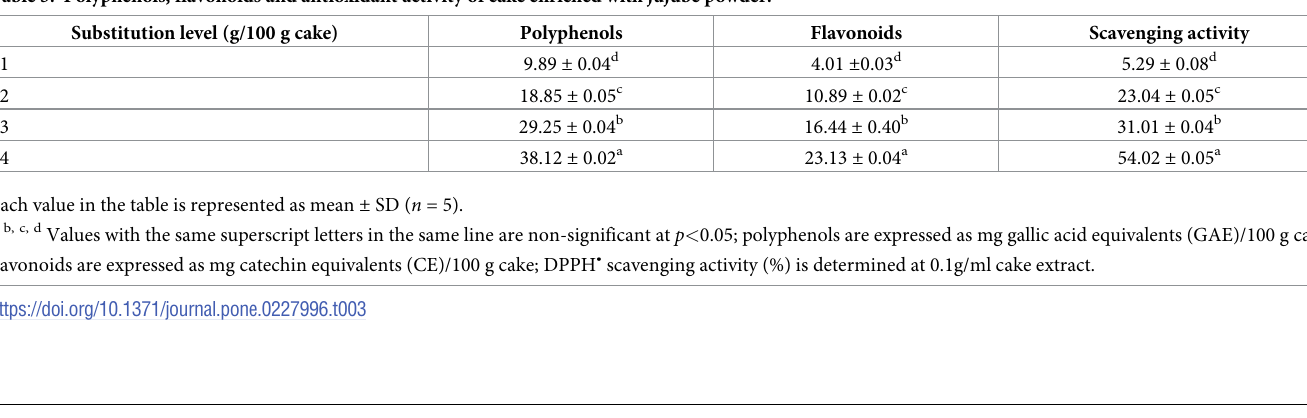
Table 3. Polyphenols, flavonoids and antioxidant activity of cake enriched with jujube powder. Substitution level (g/100 g cake)